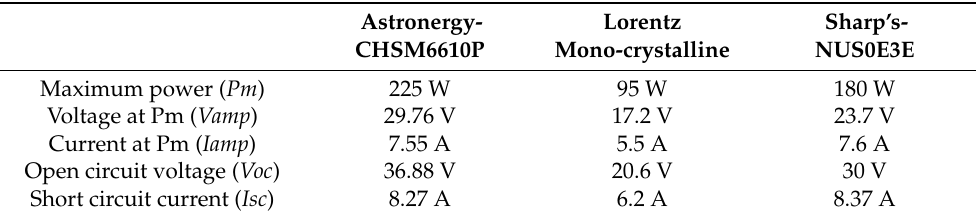
Table 1. The manufacturer specifications of the photovoltaic (PV) panels.